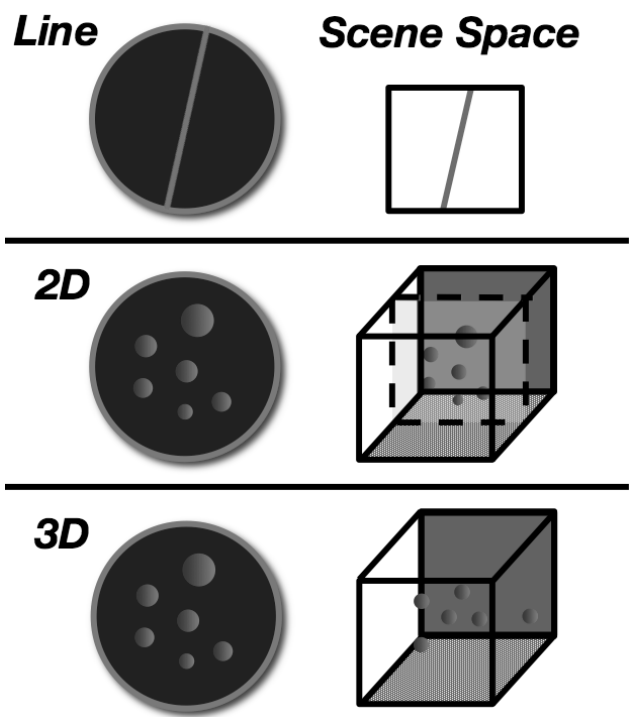
Figure 2. Illustration depicting the virtual depth of the line segment and dots in the virtual scene space shown on the displays. The top of the image shows the line segment that was drawn in 2-D space and extended across the entire display. The middle depicts the 2-D lamellar flow. The dots were drawn in different sizes on a plane positioned at the middle of the depth range (15 m) and therefore had no motion parallax. The bottom image shows the 3-D lamellar flow stimulus with dots drawn along the full virtual depth range (0.1-30 m). Static images of the 2-D and 3-D stimuli looked the same but in motion only the 3-D stimulus provided the visual cue of motion parallax.